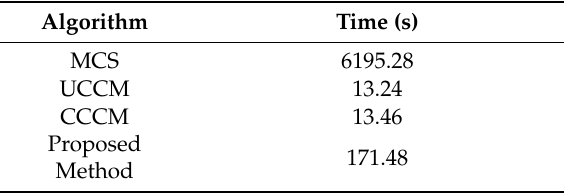
Table 10. Computation time table for the modified IEEE 118-bus test